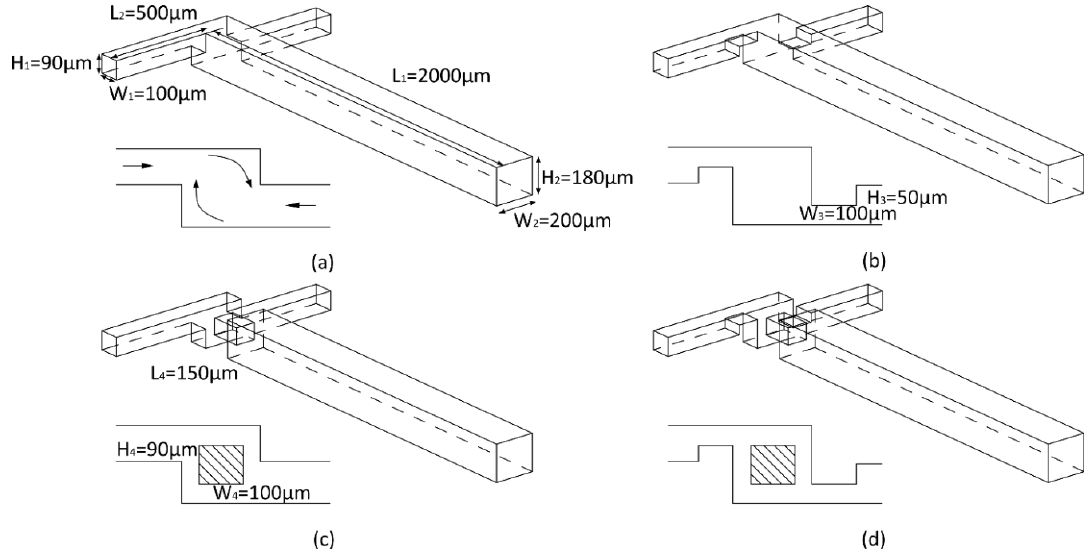
Figure 1. Isometric and top views of the 3D T-shaped micromixers: ( a ) OTM, ( b ) TMSI, ( c ) TMRC, ( d ) TMSC.